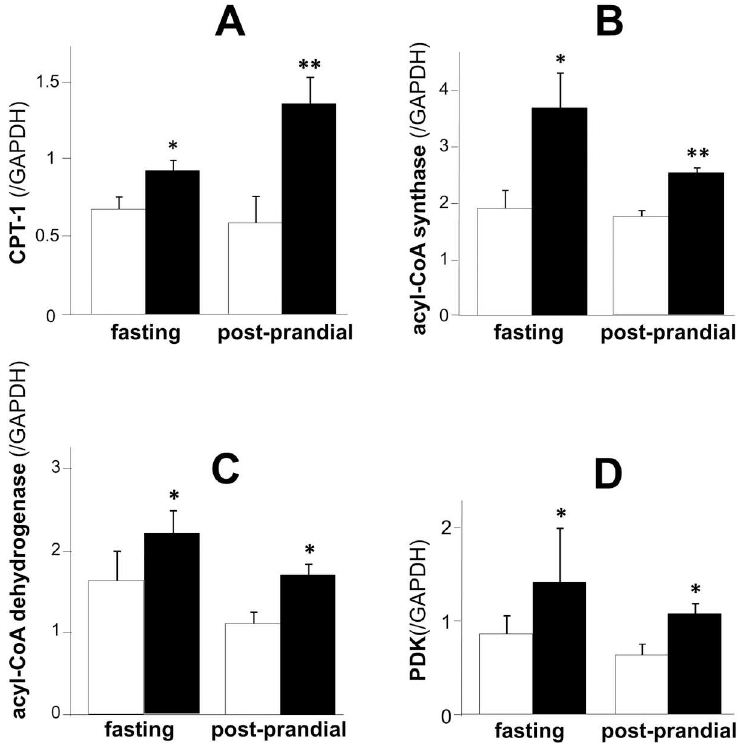
Fig 5. Fat oxidation-related gene expressions in the liver of SD rats at 15 weeks old. A; Cpt1 , B; Acs , C; Acad , D; Pdk expressioncorrected by Gapdh expression. Open bars denote control group and black bars denotemetformin-treated group. Data are presentedas mean ± S.E. (n = 6 in each group). * P < 0.05, ** P < 0.01vs. control groups.